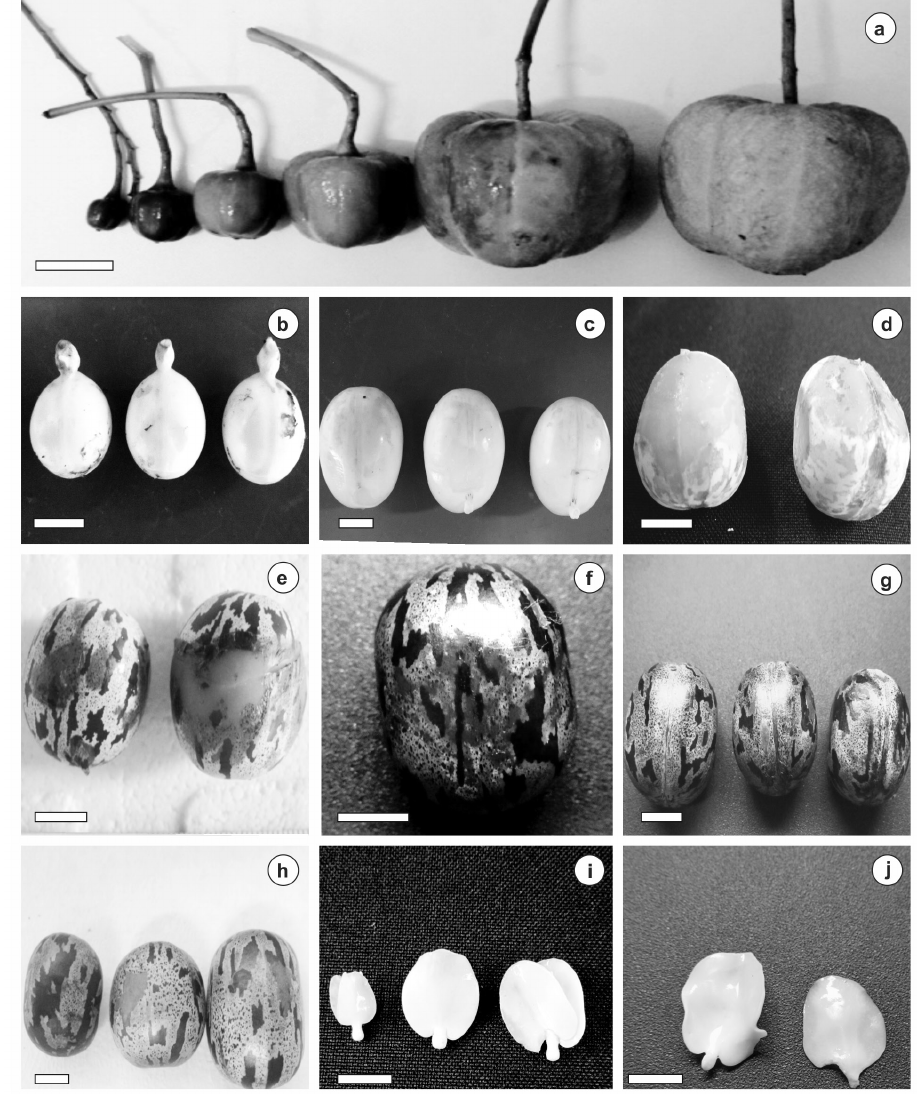
Figure 2 - Hevea brasiliensis L. fruit, during the development at 15, 30, 60, 75, 90 and 120 DAA ( a ) and seeds at 60 DAA ( b ), 90 DAA ( c ), 120 DAA ( d ), 150 DAA ( e ), 165 DAA ( f ), 175 DAA ( g ) and after dispersion ( h ). Embryo at 150, 165 and 175 DAA ( i ) and embryo after the dispersion ( j ). Bars =